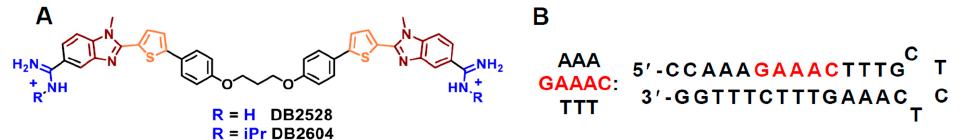
Figure 9. ( A ) Structures of minor groove binders for two G · C bps containing DNA; ( B ) DNA hairpin oligomer duplex ( B ) employed in this study.